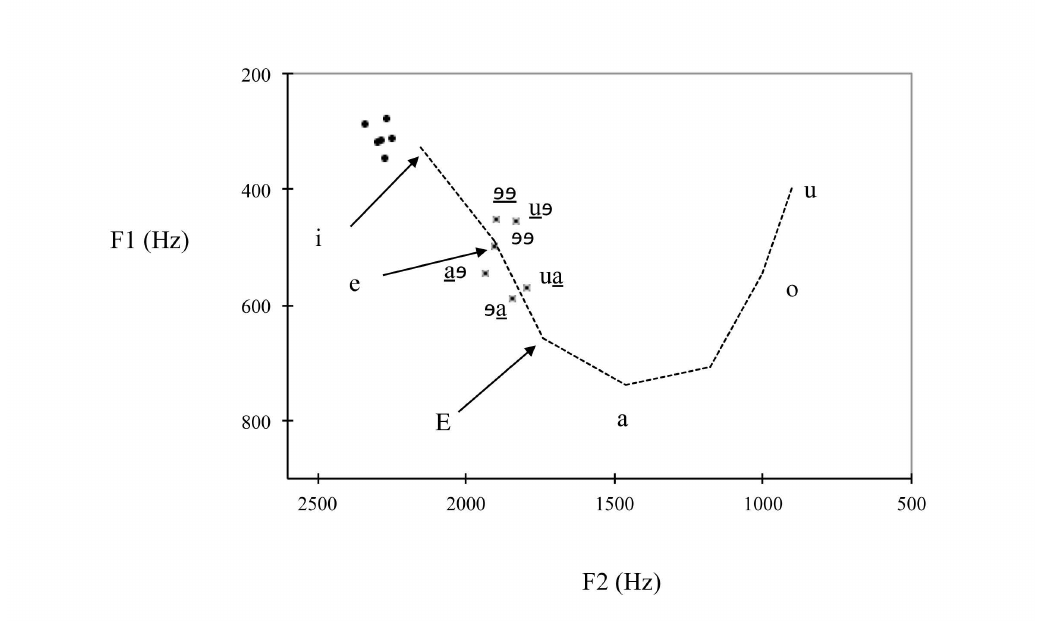
FIGURE 3. F1 x F2 values for initial and final [j] (filled circles), intervocalic [j] (crosses), and the vowels [i, e,  , a,  , o, u] averaged across the five Majorcan Catalan speakers AR, BM, MJ, ND and CA. The flanking vowels of the [VjV] sequences are given in phonetic transcription with the stressed vowels